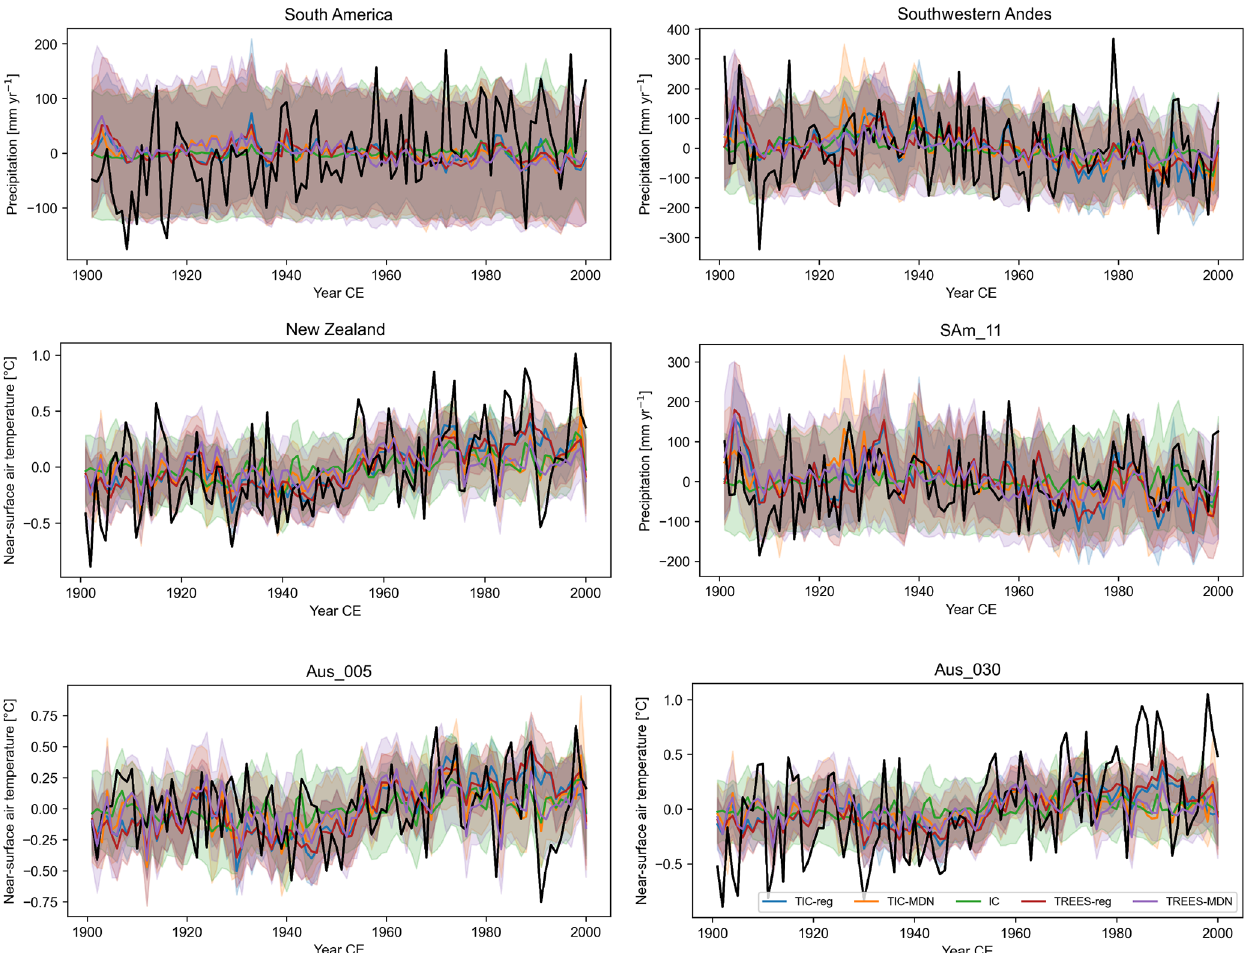
Figure 6. Reconstructed (in color) and GMF (in black) temperature (in ◦ C; relative to 1901–2000CE) or precipitation anomalies (in mmyr − 1 ; relative to 1901–2000CE) over 1901–2000CE for different DA experiments (Table 1, with ice core proxies only, with tree- ring proxies only or with both) in different regions (Sect. 3) and proxy sites (Fig. 1). Aus refers to a site in New Zealand and SAm in South America. The uncertainty (i.e., the ensemble spread; Sect. 2.1) associated with each reconstruction is represented by the shaded